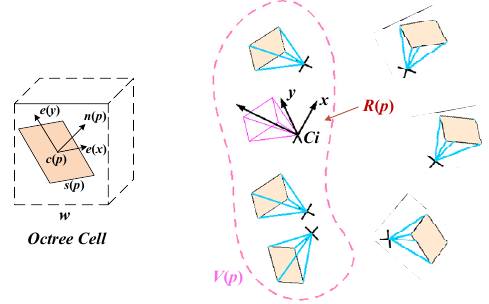
Figure 5. The schematic of the spatial geometric relationship of